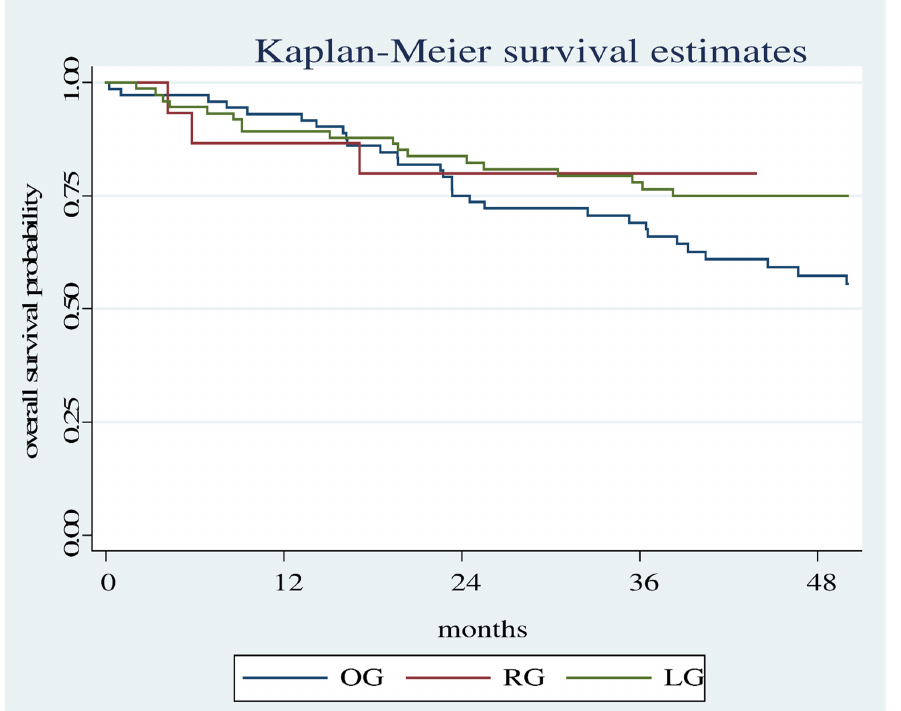
Figure 3. Overall survival estimates between the RG, OG and LG. Through Cox regression, we analyzed the factors that influenced mortality. Age (HR 1.06, p = 0.000) and stage (HR 1.34, p = 0.008) were found to be related to mortality (Table 3).